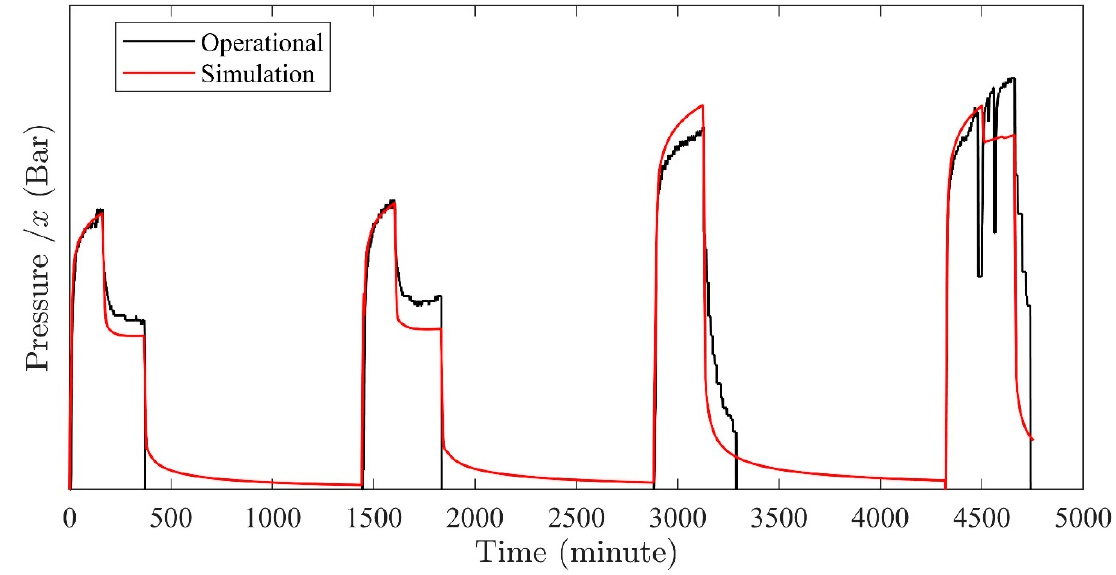
Figure 9. Matching of the operational and simulation pressure data of the UD − 2 hydraulic injec- tion/Stimulation tests to validate the simulated permeability field obtained from the UD − 1 opera- tional data.